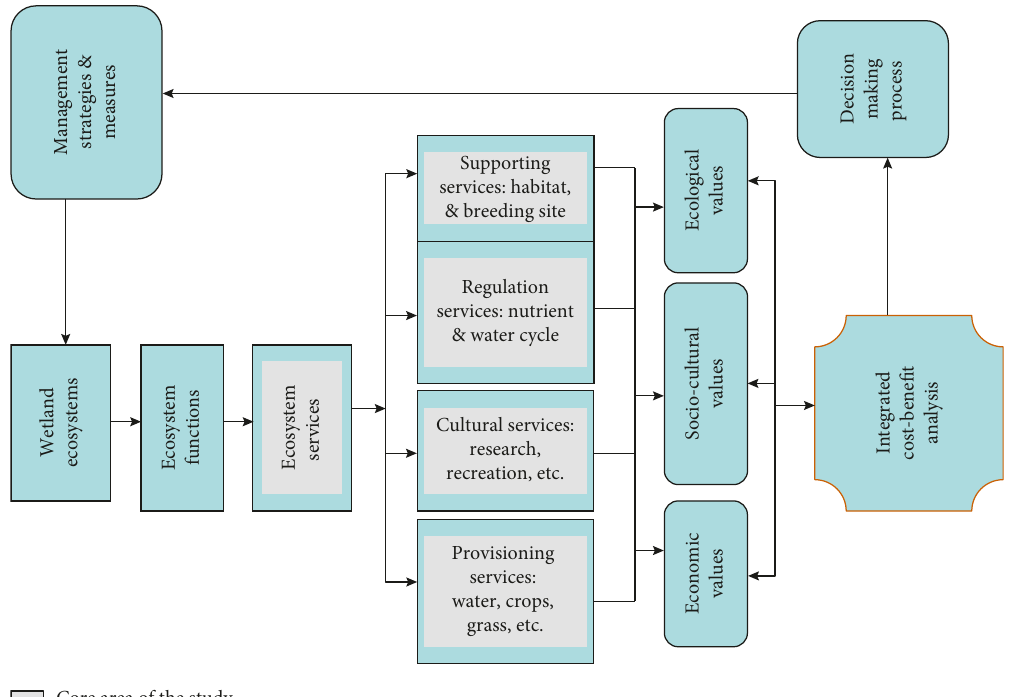
Figure 2: A conceptual model was used as a framework for the assessment and analysis of ESs [9,